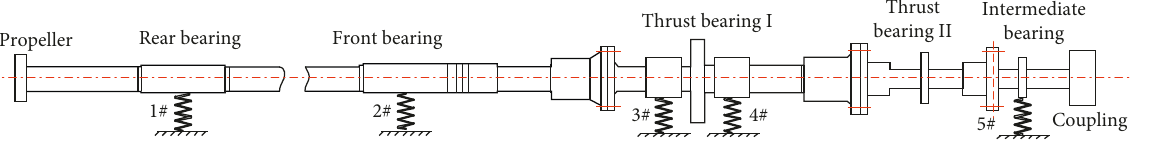
Figure 9: Schematic diagram of marine propulsion Table 1: Related parameters of each radial bearing. Table 2: Comparison of bending characteristics of shafting under different supporting conditions of thrust bearing.